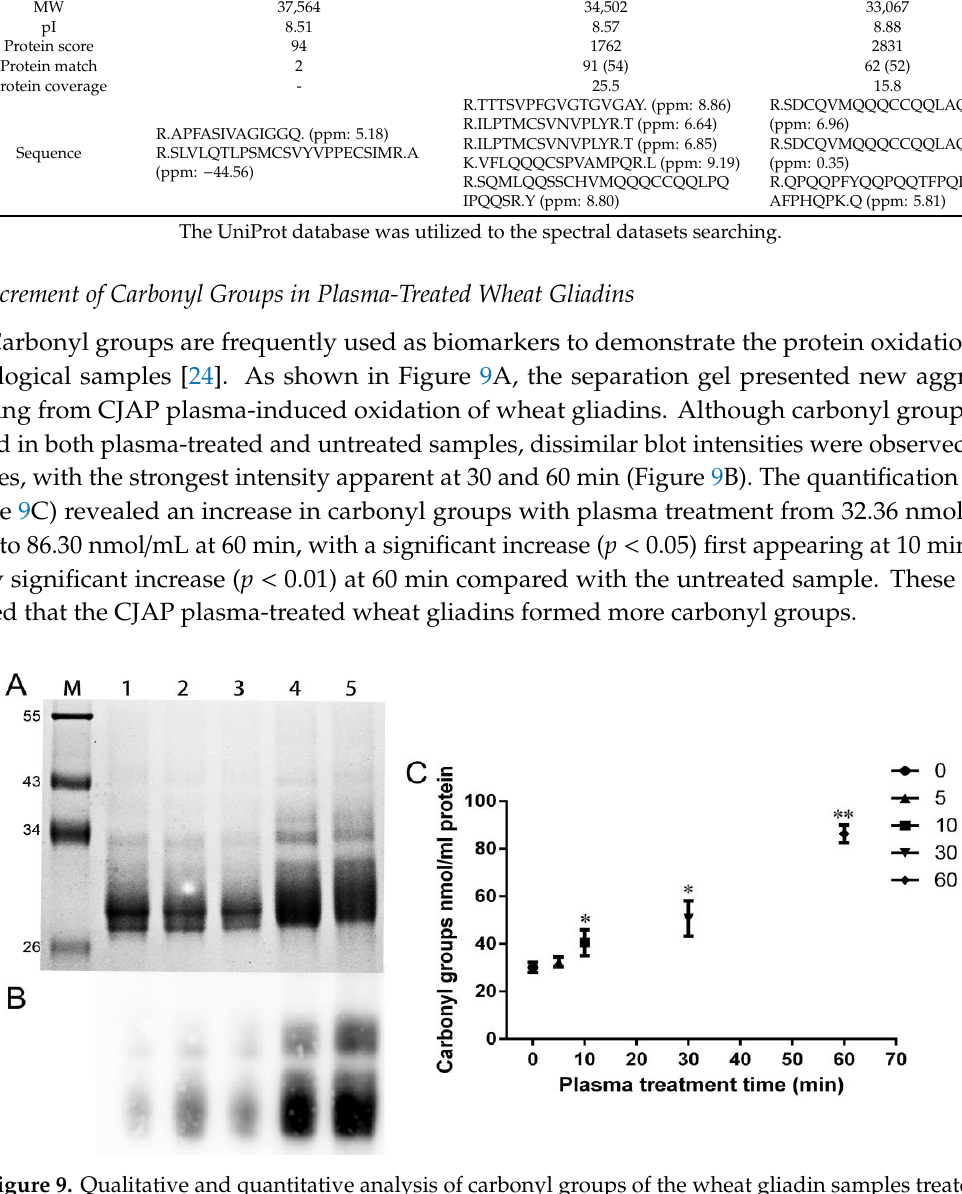
Figure 9. Qualitative and quantitative analysis of carbonyl groups of the wheat gliadin samples treated with CJAP plasma for 0 min, 5 min, 10 min, 30 min and 60 min, respectively. ( A ) SDS-PAGE gel stained with CBB. M: Protein molar mass standard, lane 1: 0 min, lane 2: 5 min, lane 3: 10 min, lane 4: 30 min, lane 5: 60 min. ( B ) Western blot of carbonyl groups using biotin-hydrazide. ( C ) Quantification of carbonyl groups using the 4-dinitrophenyl-hydrazine (DNPH) method. Data are presented as means ± SE ( n = 3) in the quantitative detection assays. Asterisks represent statistically significant differences from 0 min (* p < 0.05, ** p < 0.01).